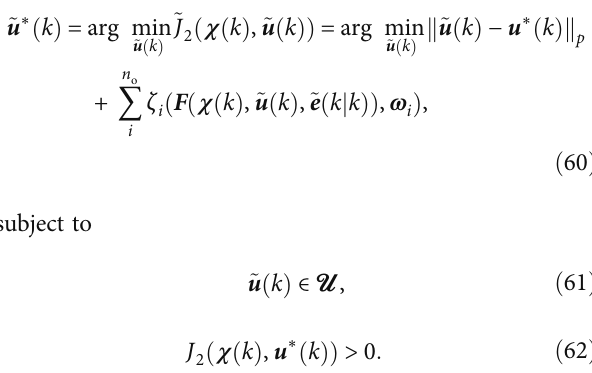
Figure 20: Flight trajectory projections of interceptor and target in case 4.